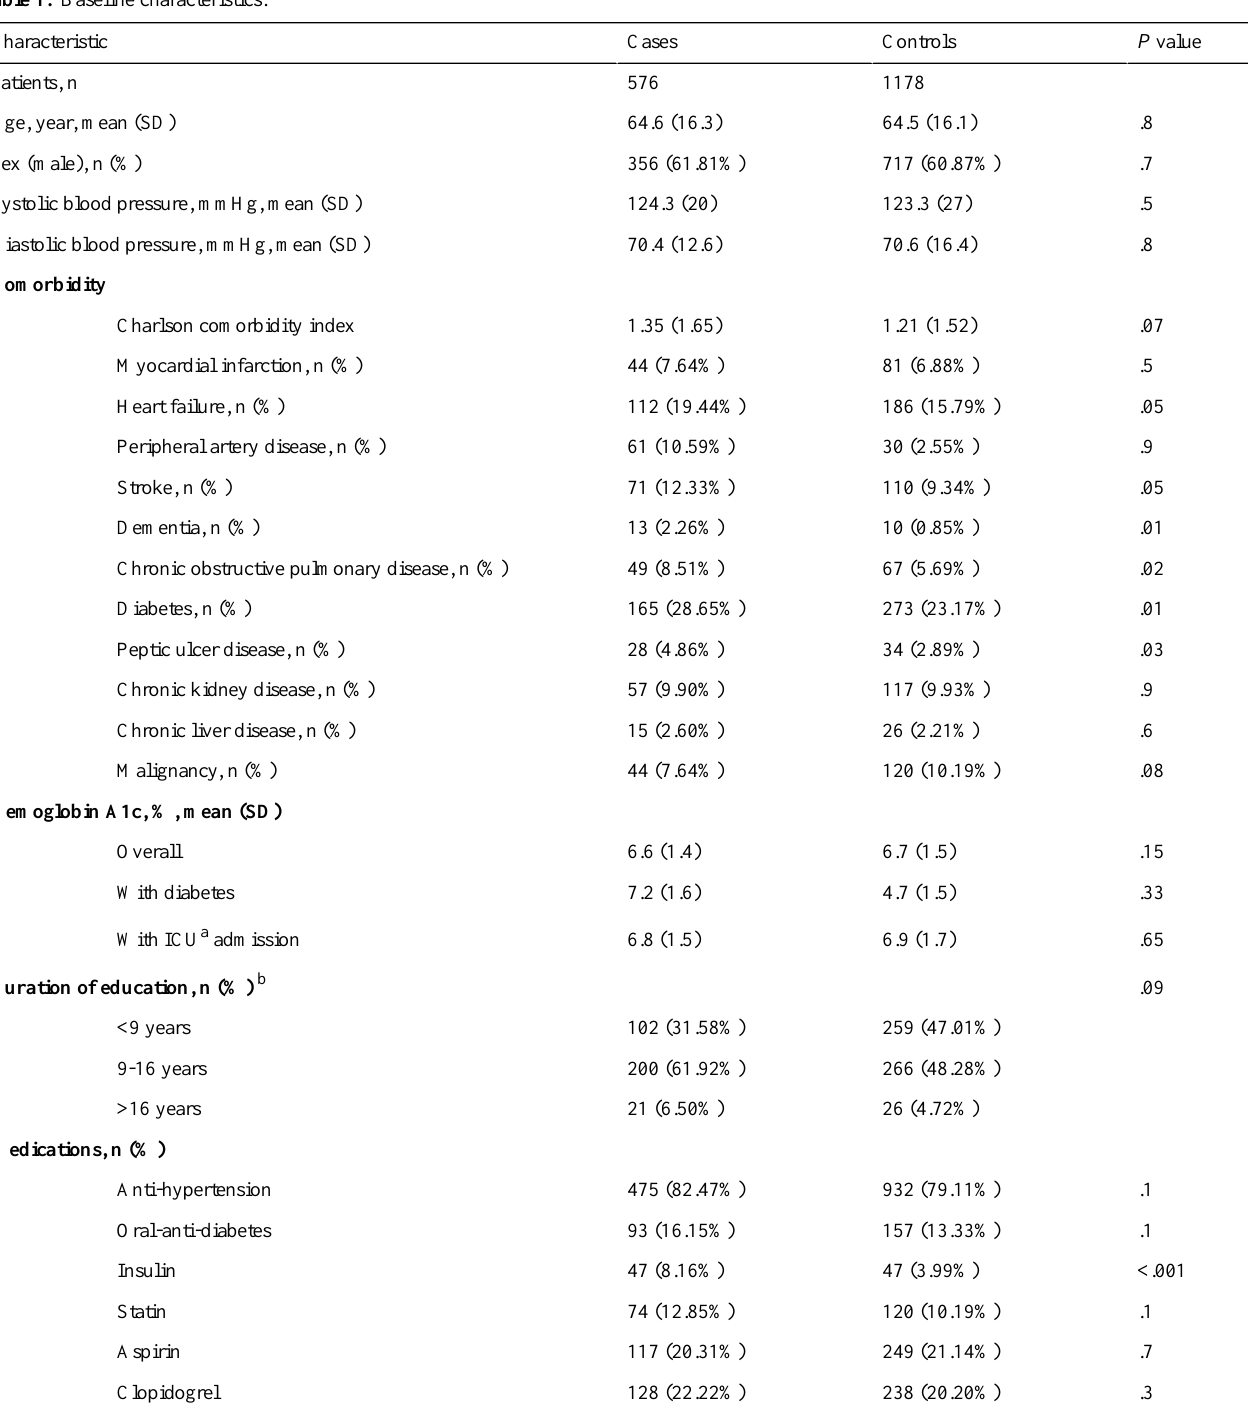
Table 1. Baseline characteristics.